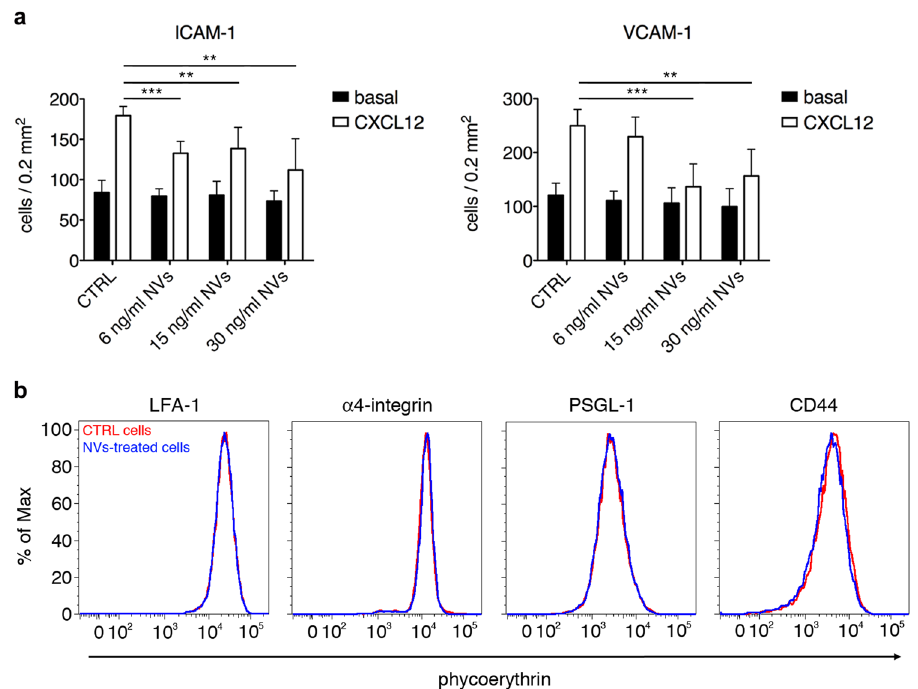
Figure 6. ASC-NVs inhibit activated T cell integrin-dependent adhesion in vitro . ( a ) MOG 35–55 -activated splenocytes from 2D2-TCR were treated for 24 hours with PBS (CTRL condition) or increasing doses of ASC-NVs. Cells were then left spontaneously adhere on purified ICAM-1 or VCAM-1 for 20 min. In some experiments, CXCL12 0.5 μ M was added for 5 min to analyze chemokine-induced adhesion. Pre-treatment with NVs significantly inhibited the integrin-dependent adhesion of activated T cells induced by chemokine CXCL12, compared to control condition (ICAM-1: cntrl CXCL12 vs NVs6 CXCL12 p = 0.00011; cntrl CXCL12 vs NVs15 CXCL12 p = 0.0049; cntrl CXCL12 vs NVs30 CXCL12 p = 0.0022. VCAM-1: cntrl CXCL12 vs NVs15 CXCL12 p = 0.00054; cntrl CXCL12 vs NVs30 CXCL12 p = 0.0061). Data are the mean ± SD of three independent experiments performed in triplicate. ( b ) Adhesion molecules expression on MOG-specific activated T cells after treatment with PBS (CTRL cells) of 30 ng/ml ASC-NVs. Red line: CTRL cells. Blue line: NV-treated